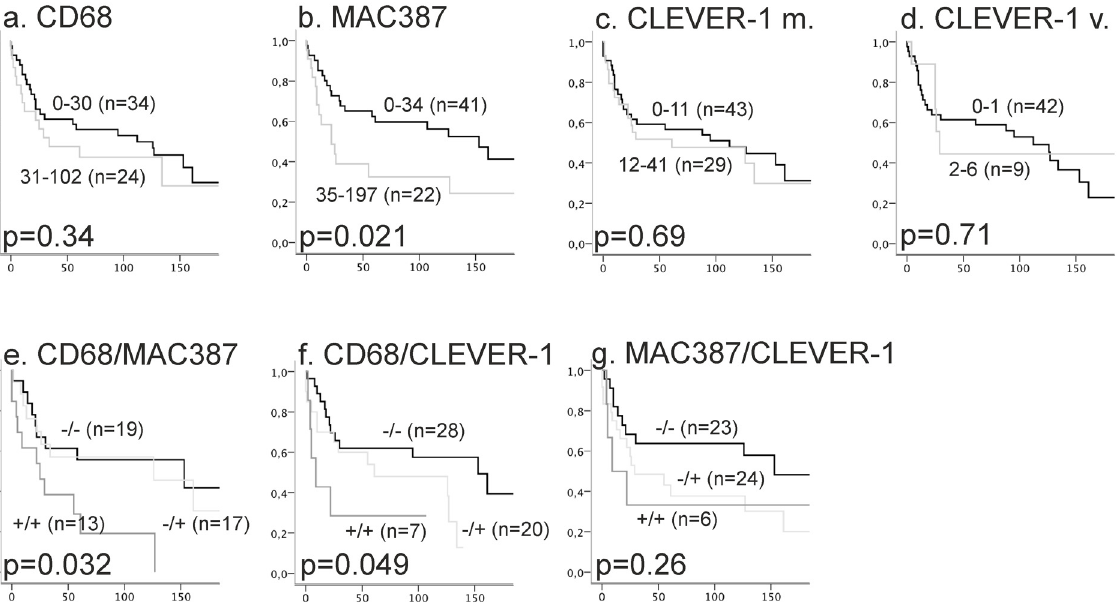
Fig 4. Kaplan-Meier estimates for OS in the RC population. The effect of CD68 + macrophages, MAC387 + macrophages, and CLEVER-1/Stabilin-1 + macrophages/vessels on the OS in the radical cystectomy population (a-d). The association between OS and the expression of two macrophage markers